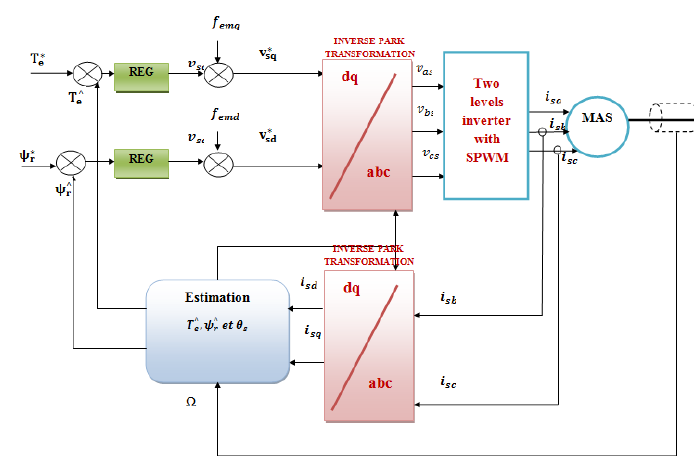
Figure 2. DFOC strategy scheme of asynchronous machine using 2 L.